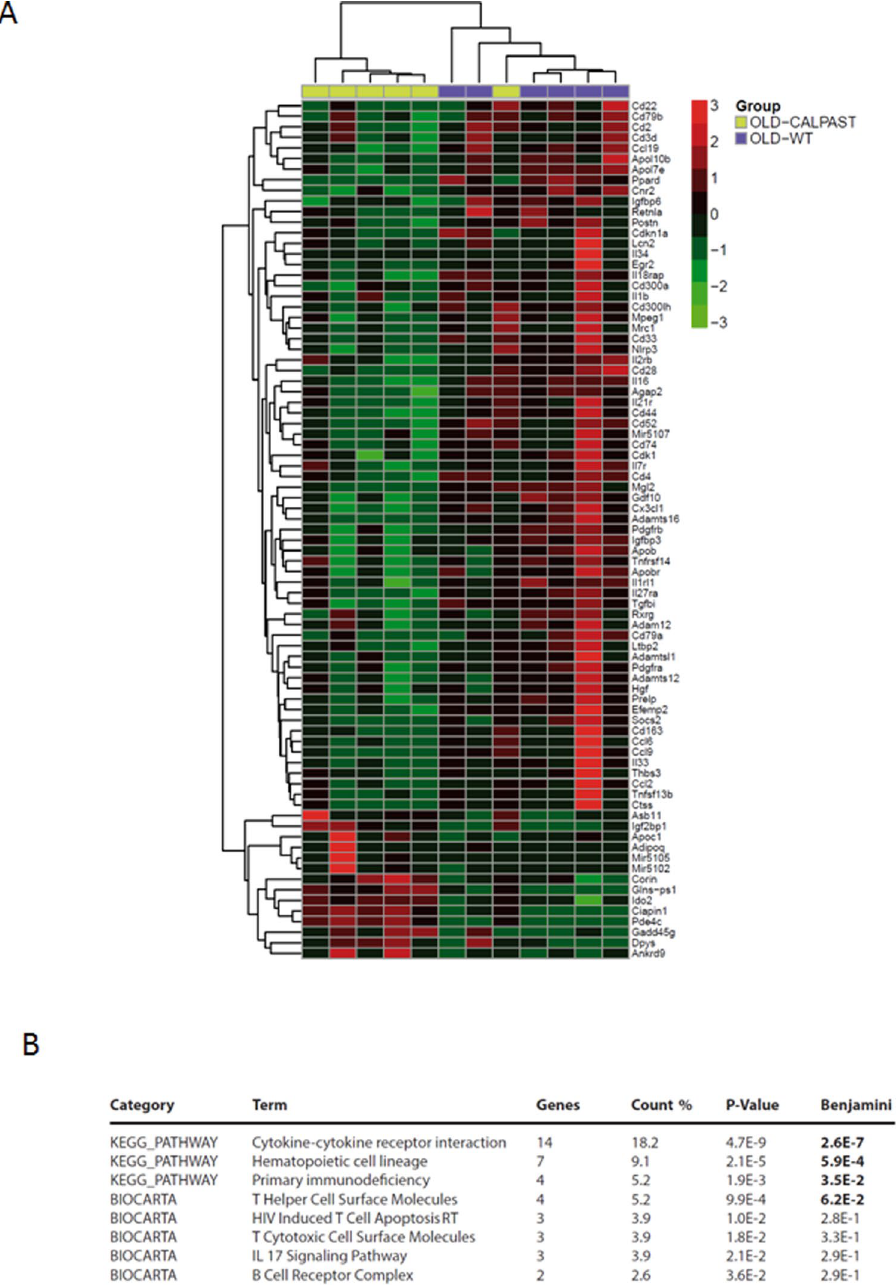
Figure 9. Genes differentially expressed in aged WT and CalpTG mice are related to inflammatory pathways. Heatmap representation of genes differentially expressed between old WT and CalpTG (TG) mice. Eighty- two renal-expressed transcripts have been found significantly differentially expressed between groups. Corresponding genes were represented using the Pheatmap R package, unsupervised clustering, Manhattan method ( A , n = 6/group). Kegg and biocarta pathways found significantly enriched when comparing old WT and CalpTG mice ( B ). Pathways are immune related suggesting that large parts of difference observed are associated with inflammaging-related